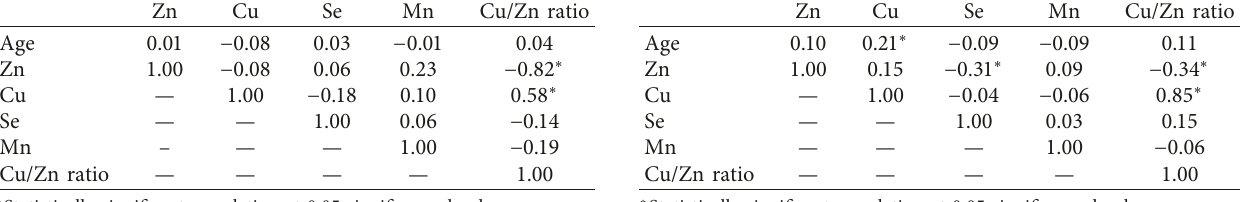
Statistically significant correlation at 0.05 significance